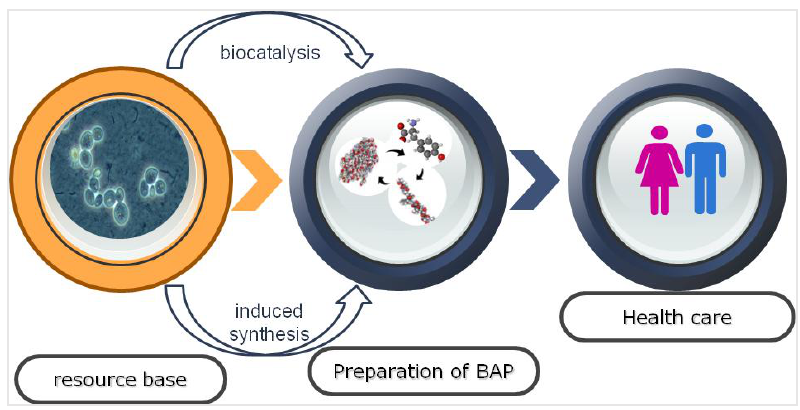
Figure 1. S. cerevisiae as a source of biologically active peptides (BAP).